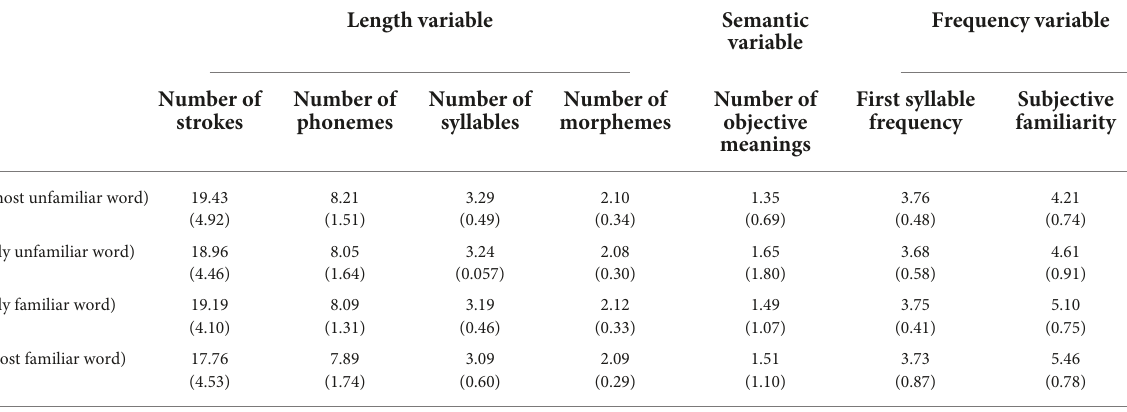
TABLE 3 Descriptive statistics of each level in subjective familiarity condition.